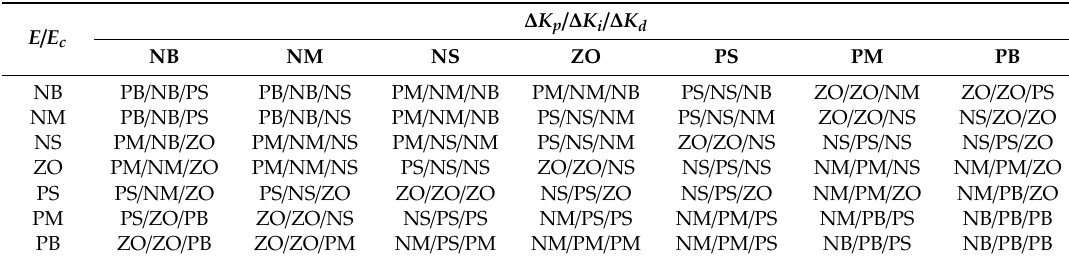
Table 2. The control rules of the fuzzy